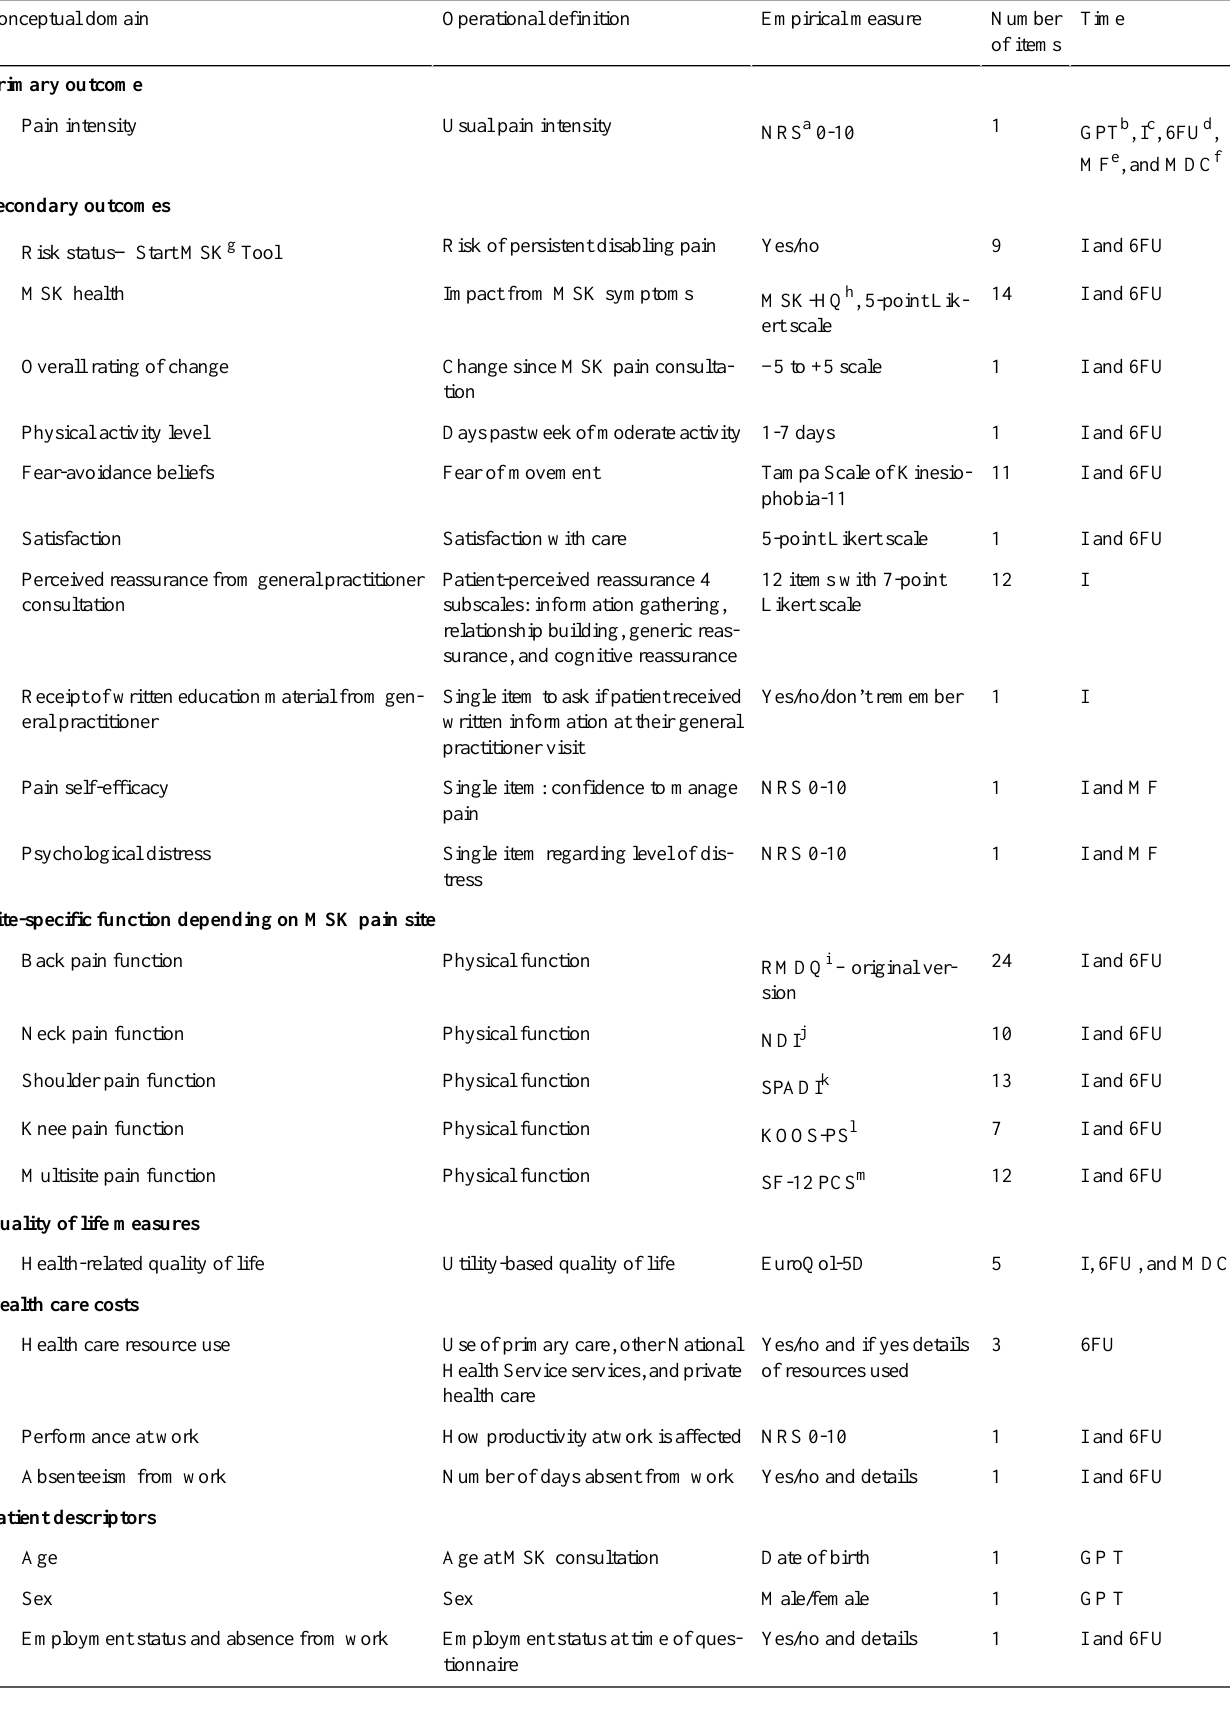
Table 1. A summary of patient-reported data